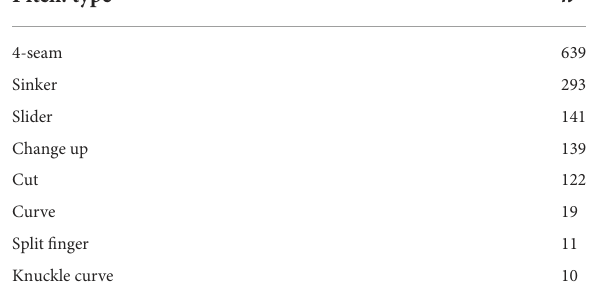
TABLE 1 Number of data points for each type of pitch. Pitch.